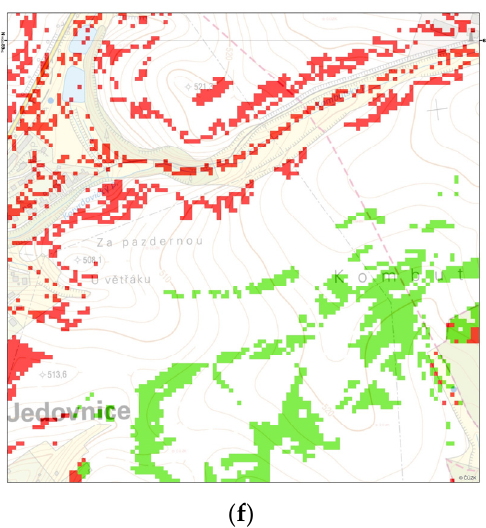
Figure 12. Di ff erences in cost maps of landscape potential for DS deployment for MCA variants from the Jedovnice area in relation to the Experts variant: ( a ) Experts cost map, ( b ) di ff erences with the Theorists variant, ( c ) di ff erences with the Var. 3 variant, ( d ) di ff erences with the Pairs variant, ( e ) di ff erences with the MES variant, ( f ) di ff erences with the Saaty variant. Legend: red indicates the di ff erence − 1, green the di ff erence + 1, white identical